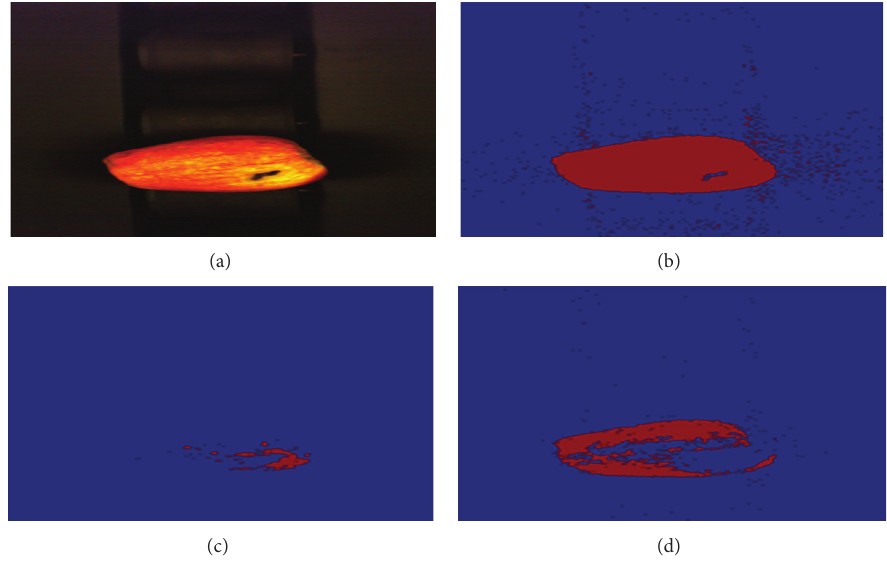
Figure 5: (a) Original image. Thresholding results of the (b) “ 𝑆 ” component of HSV color space, (c) “ 𝑌 ” component of CIE 𝑋𝑌𝑍 color space, and (d) “ 𝑎 ” component of CIE 𝐿 ∗ 𝑎 ∗ 𝑏 ∗ color space.